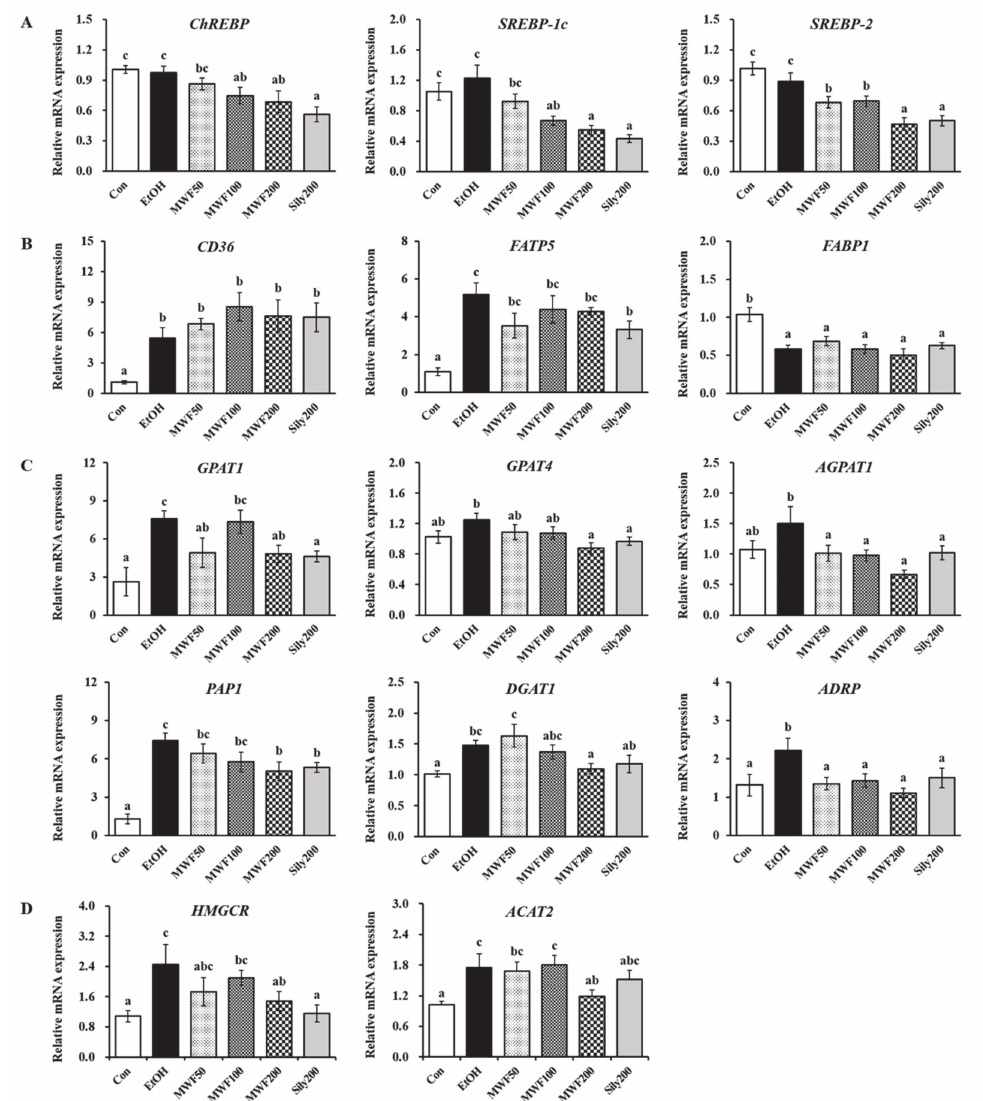
Figure 2. E ff ects of MWF on the hepatic lipogenesis-related gene levels in chronic alcohol-fed rats. ( A ) Lipid synthesis transcription factors; ( B ) fatty acid uptake and transport-related genes; ( C ) triglyceride synthesis-related genes; ( D ) cholesterol synthesis and esterification-related